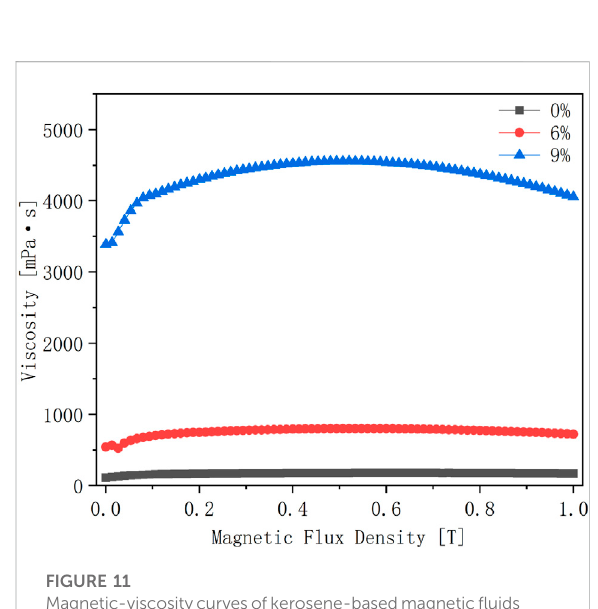
FIGURE 11 Magnetic-viscositycurvesofkerosene-basedmagnetic fl uids with different evaporation rates at a shear rate of 100 S − 1